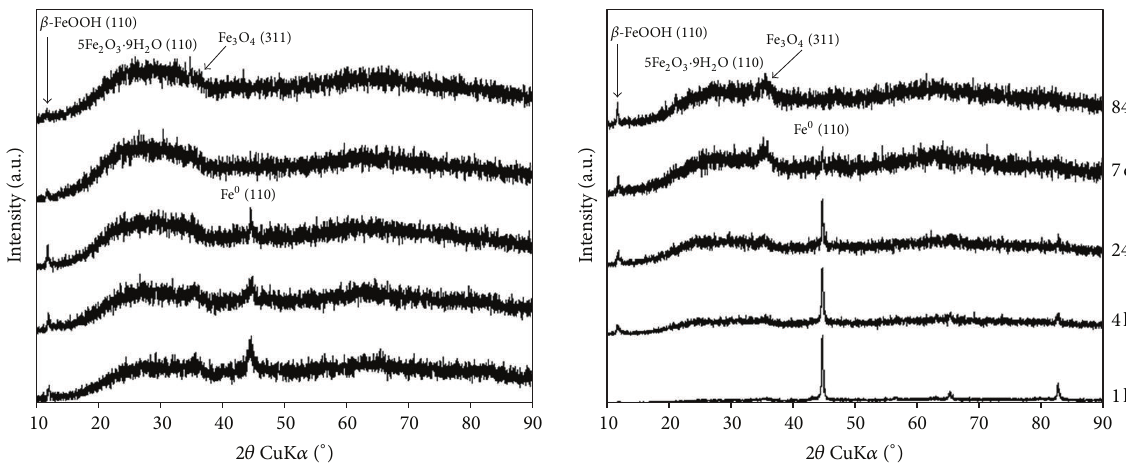
Figure 6: X-ray diffraction (XRD) spectra (for the range of 10–90 ∘ 2 𝜃 ) recorded for the mine water batch systems containing as-formed (LHS) and vacuum annealed (RHS) nano-Fe 0 extracted at reaction times of 1h, 4h, 24h, 7d, and 84 d.